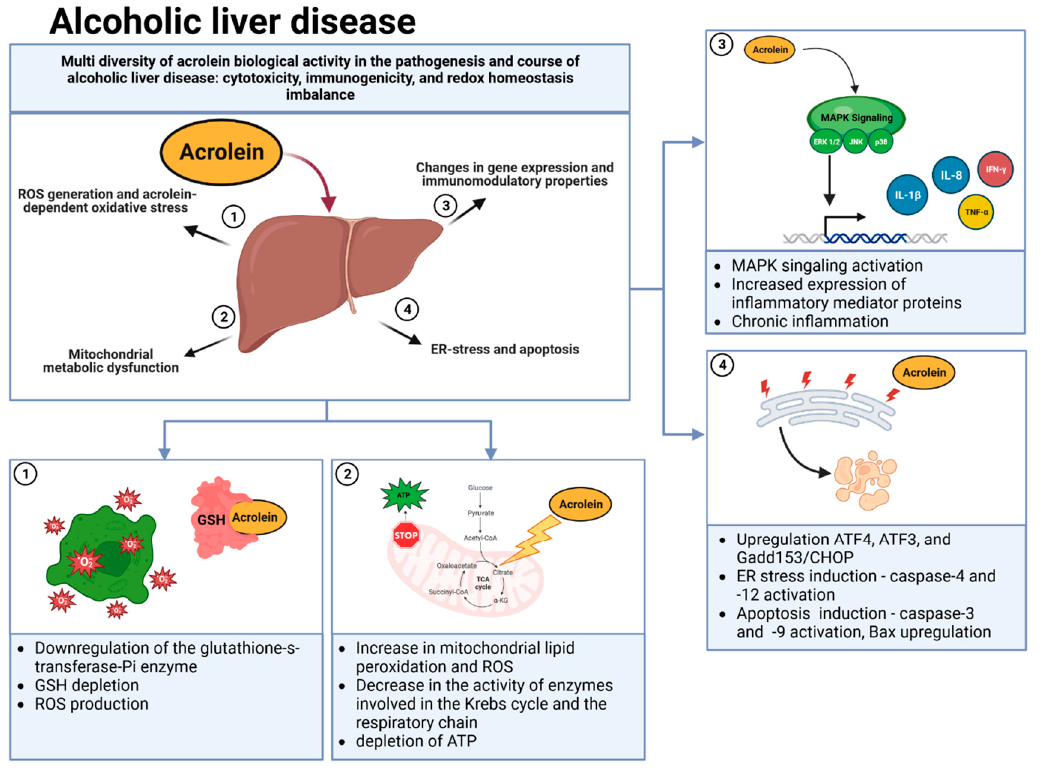
Figure 2. Schematic representation of the potential mechanisms of action of acrolein in the develop- ment and progression of alcoholic liver disease: (1) GSH depletion and redox homeostasis disorders, (2) inhibition of mitochondrial biochemical activity, (3) immunogenic and pro-inflammatory proper- ties, (4) induction of ER stress and